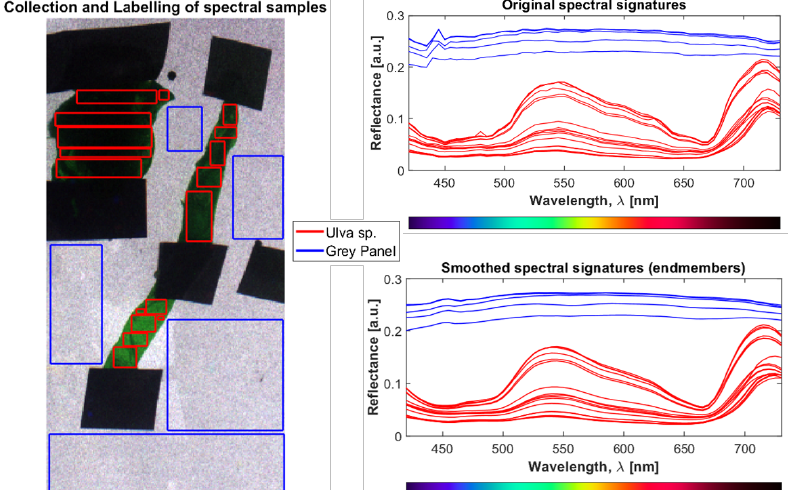
Figure 6. Example of labeling procedure for Ulva sp. and “gray panel” samples. On the left, annotated pixels selected from rectangular regions of interest (ROIs) of the hypercube. On the right, the raw reflectance spectra and respective smoothed spectra. For representation simplicity, each curve represents the average within a ROI, although all enclosed the individual pixel signatures were added to the dataset. The reduction of noisy features through low pass filtering is noticeable (e.g., gray panel at 450 nm); broadband spectral features are preserved. Intra-species variability is visually noticed when comparing the dense multi-layer patch on the top left with the light green section in the